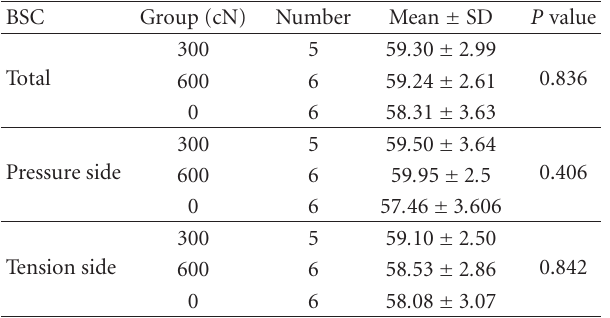
Table 2: Statistical indices for lamellar bone around mini-screw within 2mm at pressure side and at tension side.